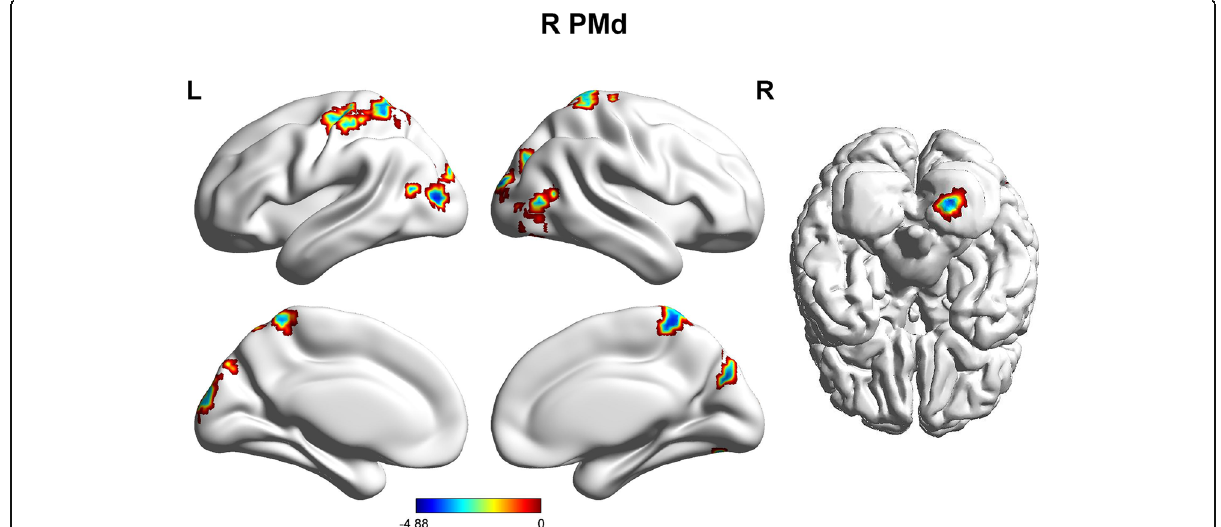
Fig. 4 Sagittal views of the MNI brain areas showing reduced intrinsic functional connectivity (FC) with the PMd in MWoAs compared to healthy controls. The surviving clusters were assigned thresholds at p < 0.001 (voxel level) and were FWE corrected to p < 0.05 at the cluster level